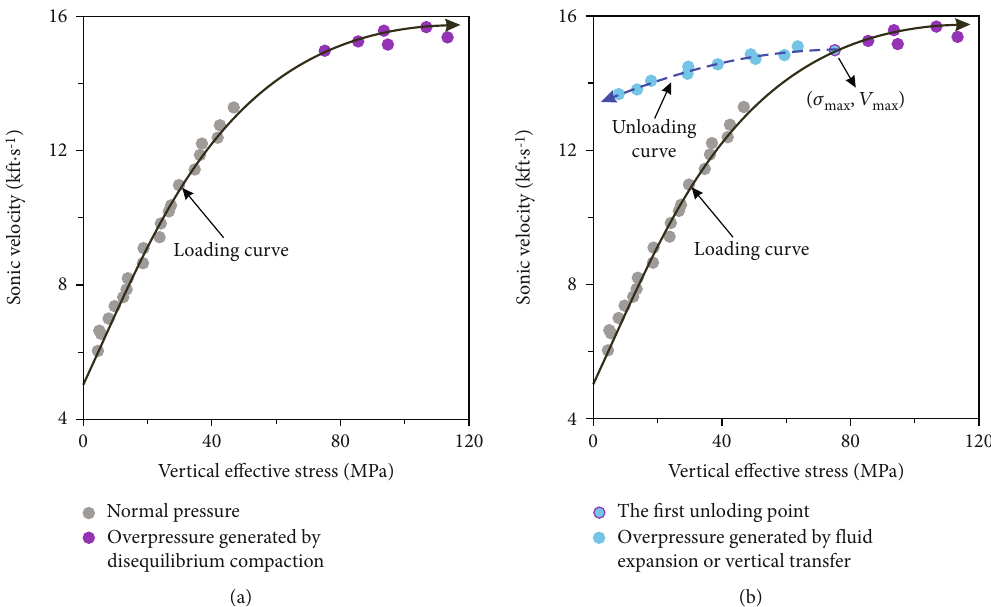
Figure 4: Loading-unloading curve of mudstone constructed by the vertical e ff ective stress and sonic velocity and the identi fi cation of overpressure mechanisms (modi fi ed from